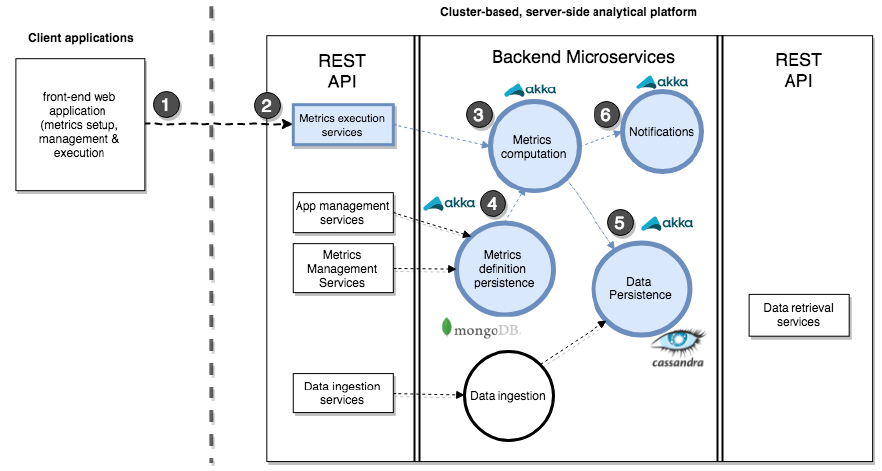
Figure 8. Coloured in blue microservices involved in the metric computation phase.